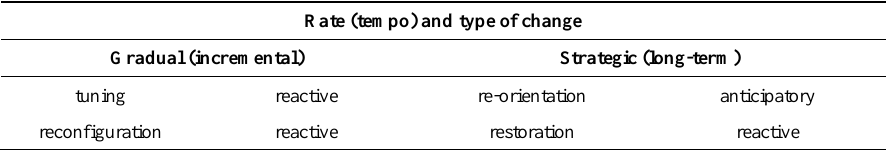
Table 6. Four-field adaptation